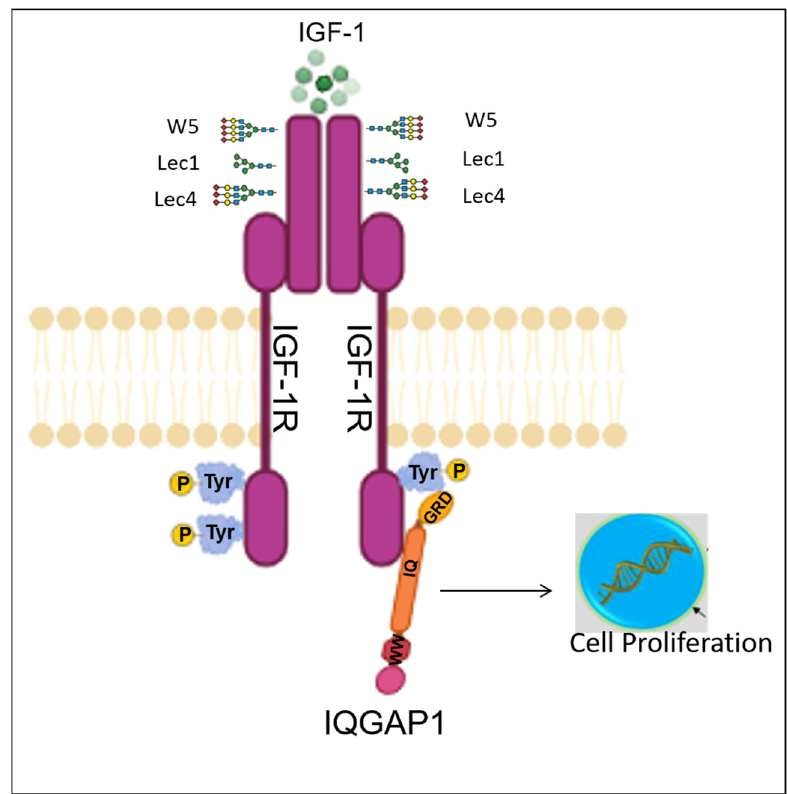
Figure 10. The proposed mechanism for the regulation of IGF-1R signaling and cell proliferation by the N -glycosylation sites. We assume that in W5 cells, IGF-1R possesses mostly complex N-glycan structures. In Lec1 and Lec4 cells, due to the loss of N-glycosylation, oligomannose N-glycans or trianteannary N-glycan structures are formed in IGF-1R. Lec1 and Lec4 cells contain limiting IGF-1R glycan branching structures which reduce cell surface localization and can turn off the IGF-1R–IQGAP1–ERK complex formation. This might result in inhibition of IGF-1R-related cellular